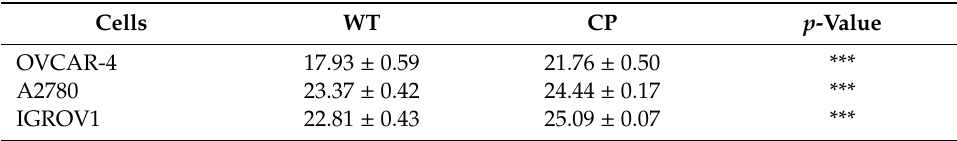
Table 2. Signal-to-noise (S / N) ratio of gray level co-occurrence matrix (GLCM) texture feature for wild type (WT) and cisplatin-resistant (CP) ovarian adenocarcinoma